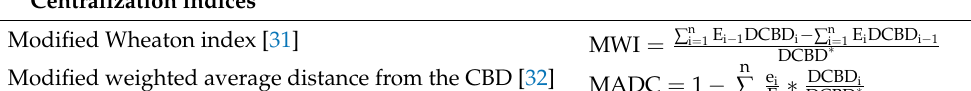
Table 1. Indices for the two dimensions of polycentricity. Centralization